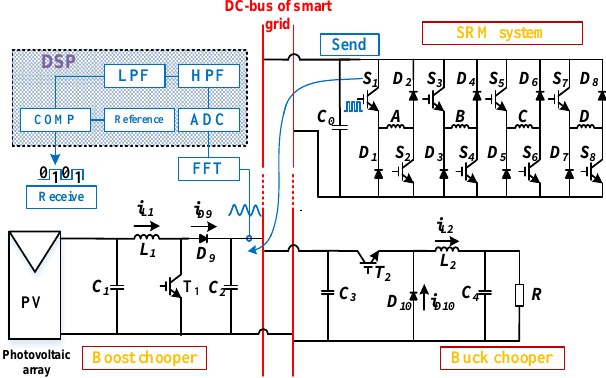
Figure 27. Schematic of the experimental plant.